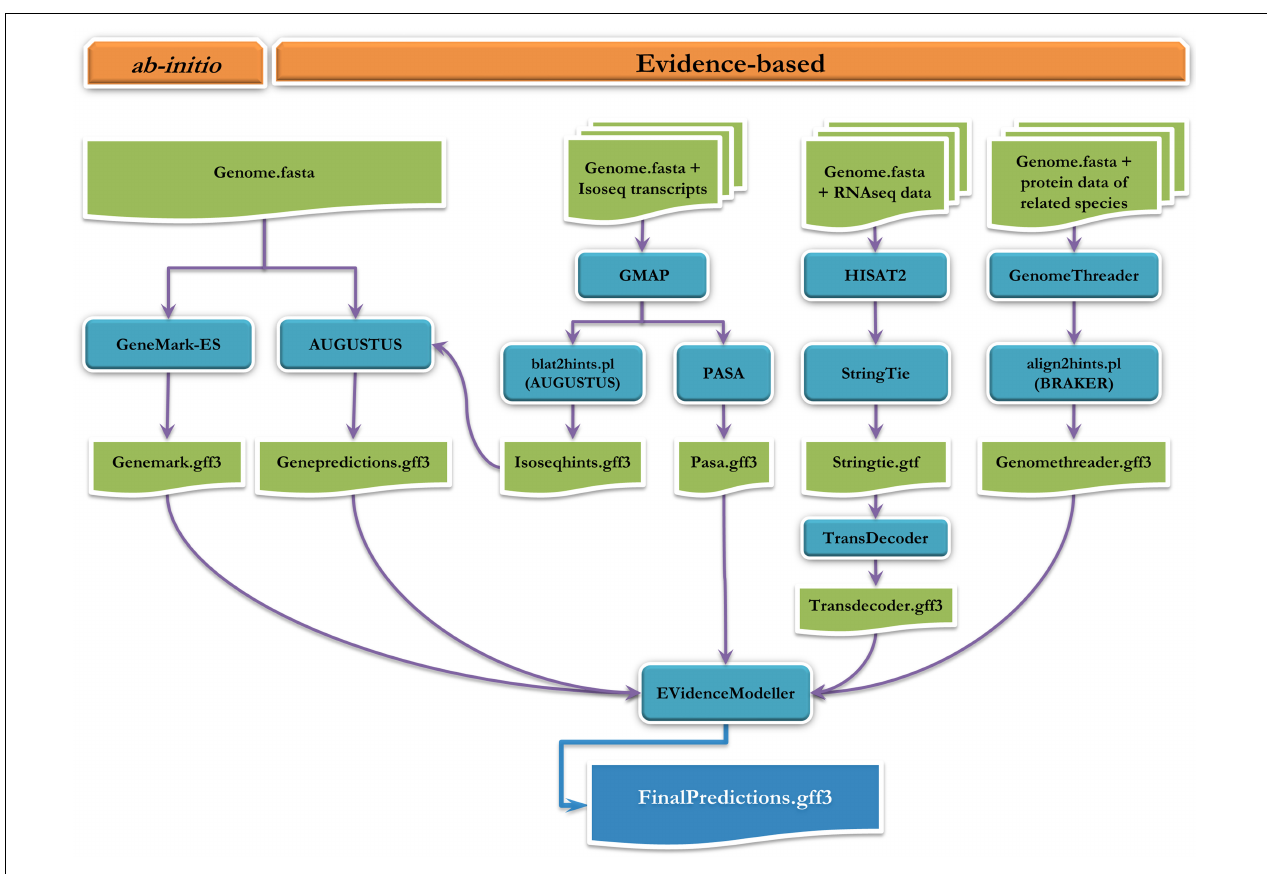
FIGURE 3 | Workflow followed for predicting protein-coding genes in assembly of P. indicus genome.